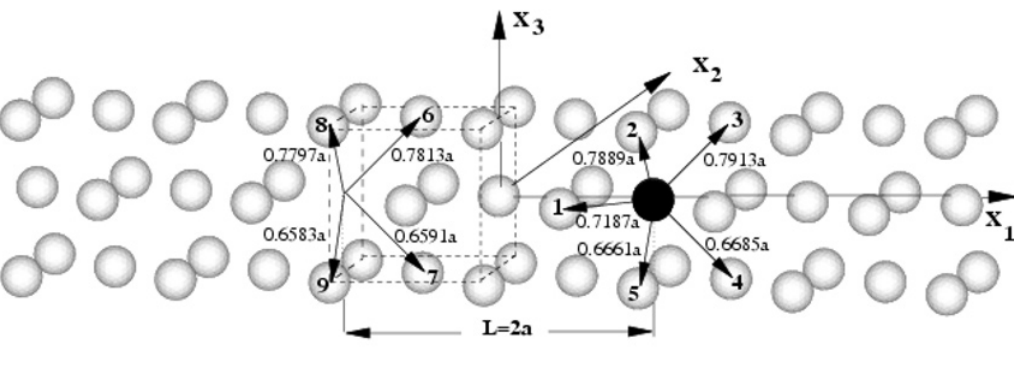
Figure 4. Lattice distortion in the vicinities of a dopant and a vacancy for L